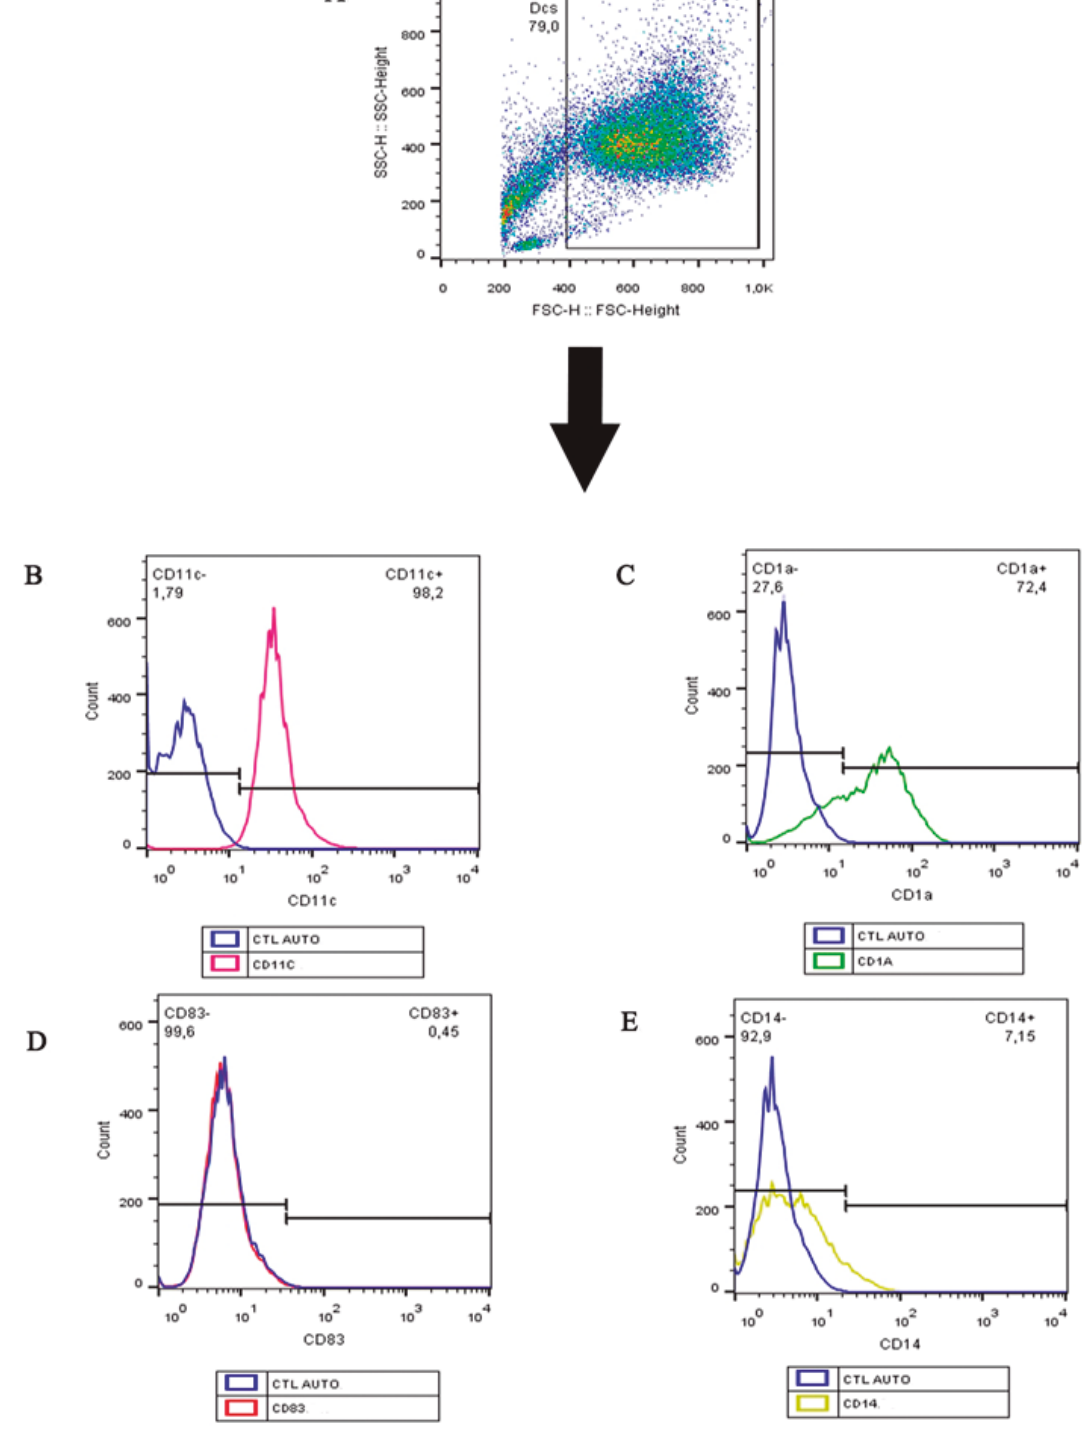
Figure 1. Dendritic cell phenotype after monocyte incubation with IL-4 and GM-CSF. (A) Dot plot related to size (FSC-H) x granularity (SSC-H). Histograms represent cell surface markers: (B) CD11c high , (C) CD1a high , (D) CD83 low and (E) CD14 low